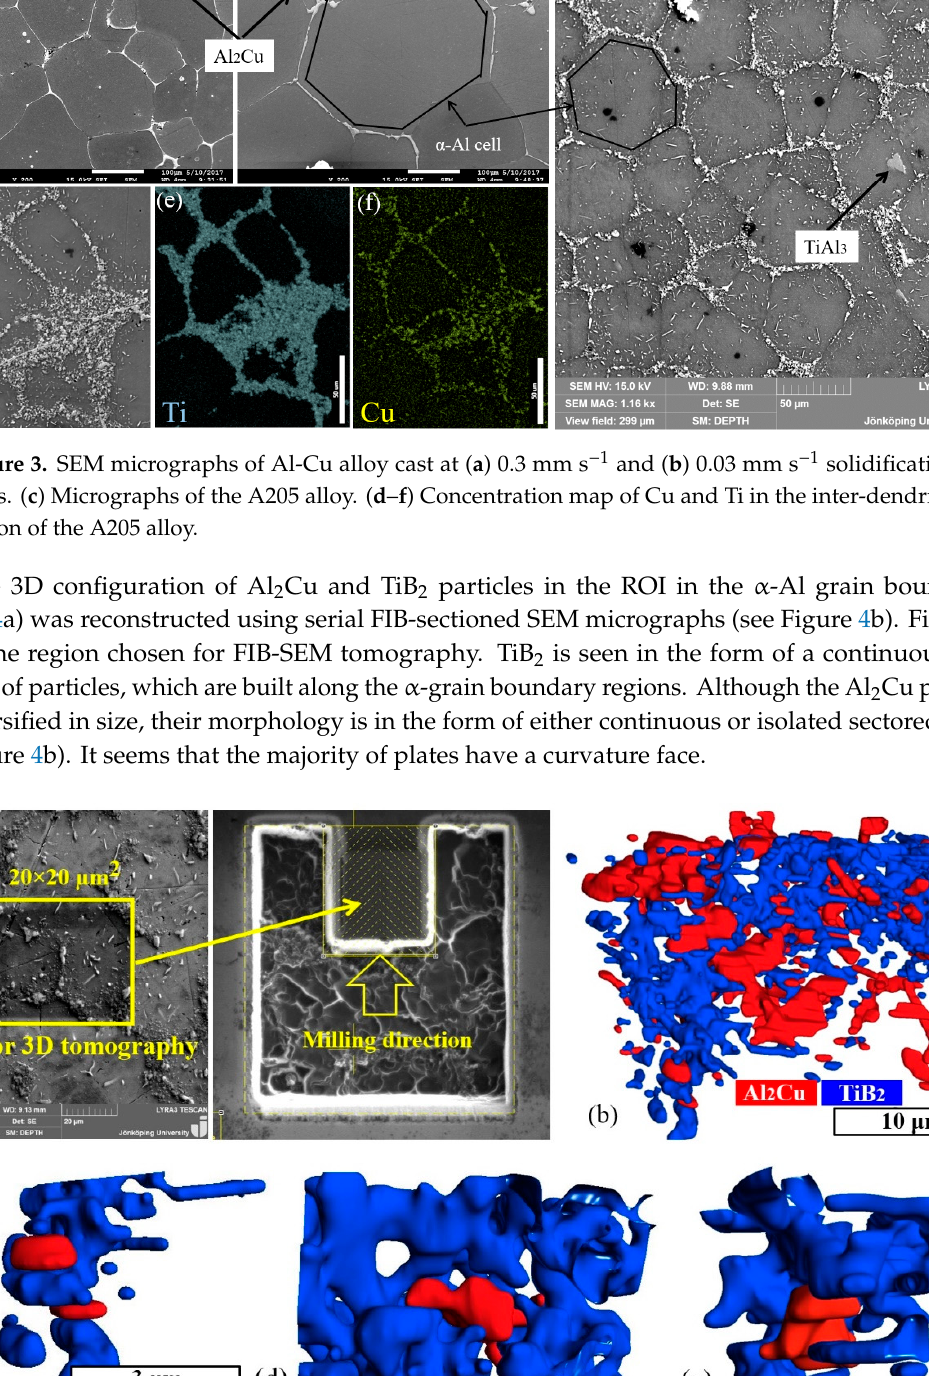
Figure 5. ( a ) SEM micrographs of secondary electron (SE) image and ( b ) backscattered electron (BSE) image of the ROI for the as-cast A205 alloy.